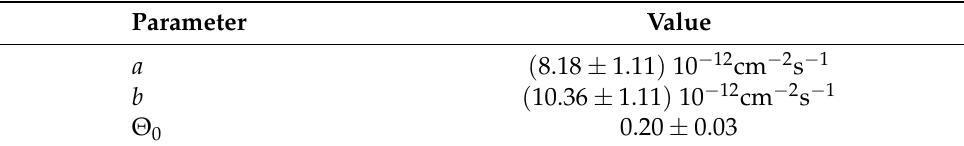
Table 1. Values of the parameters resulting from fitting the TeV data of Figure 1 with a sine function of the form given in Equation (3).